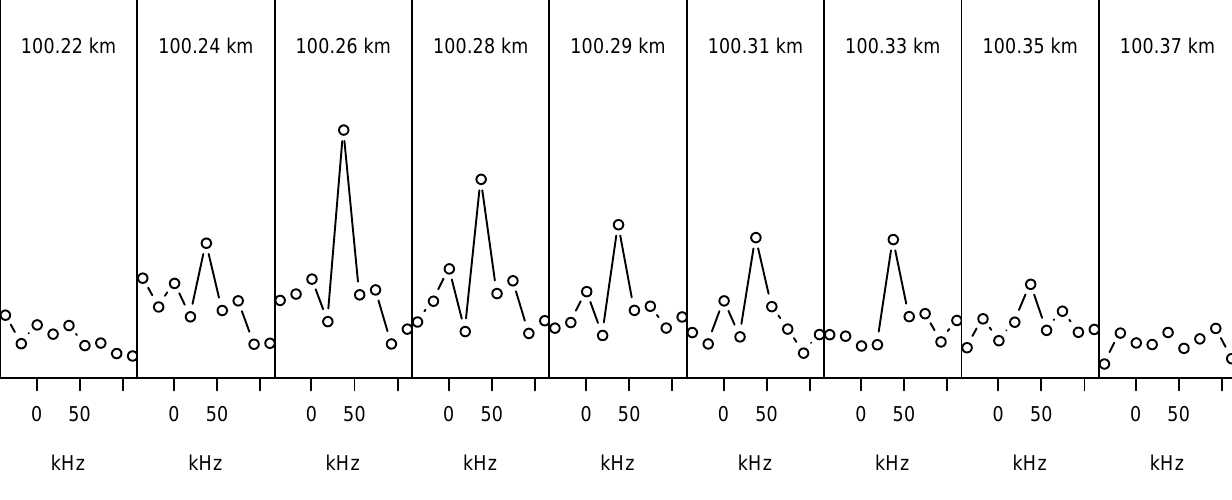
Fig. 7. The modulus of the Fourier series coefficients c j,k . The meteor head echo is about 100m wide and the main 40kHz Doppler shift dominates the